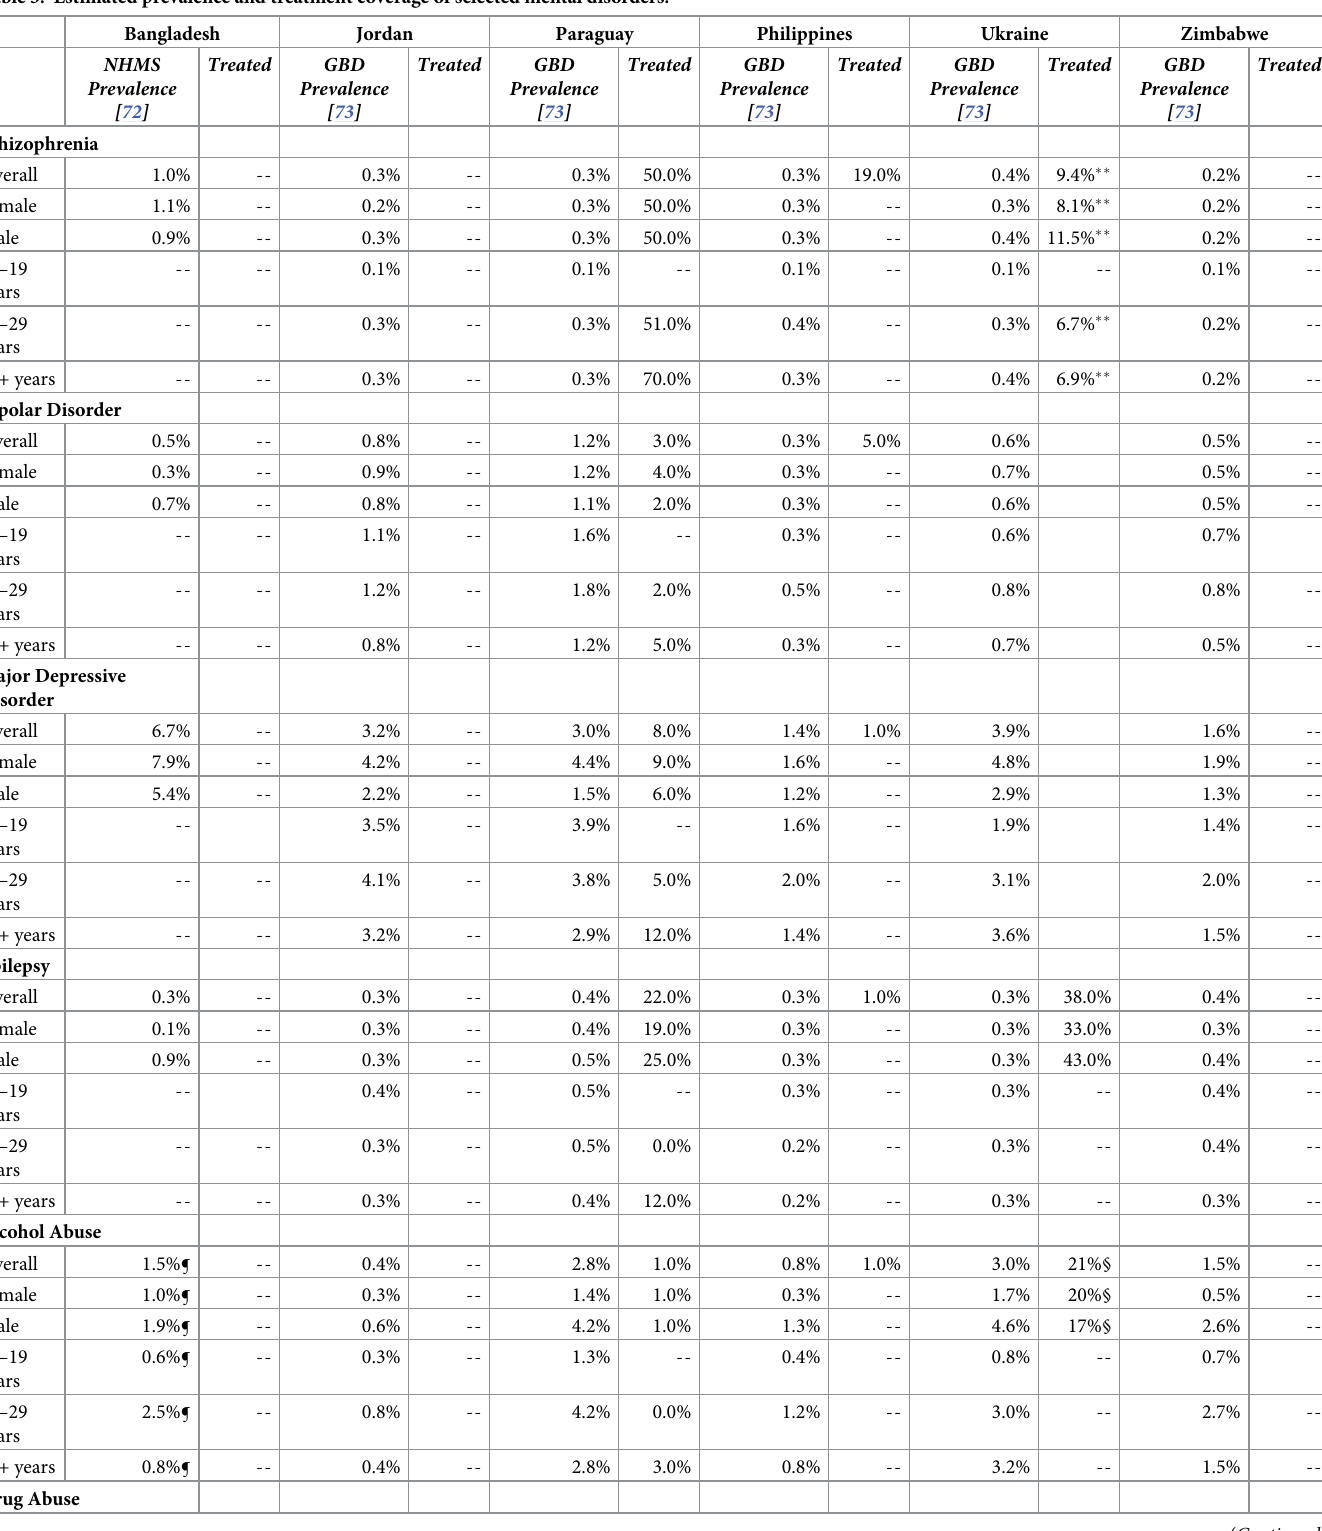
Table 3. Estimated prevalence and treatment coverage of selected mental disorders.